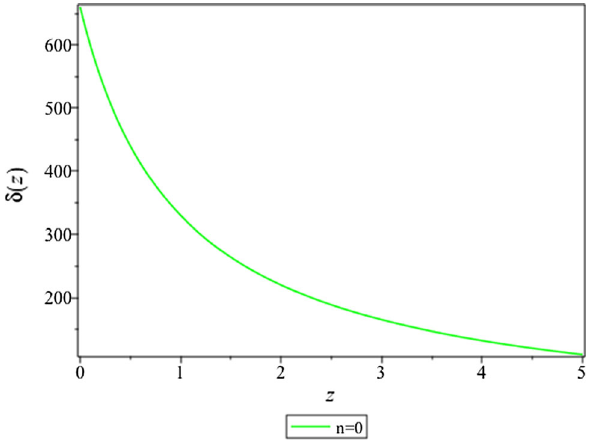
Fig. 7 The growth of velocity contrast versus cosmological redshift for the generalized f ( T ) model for the system of Eqs. (133)–(138) for n =